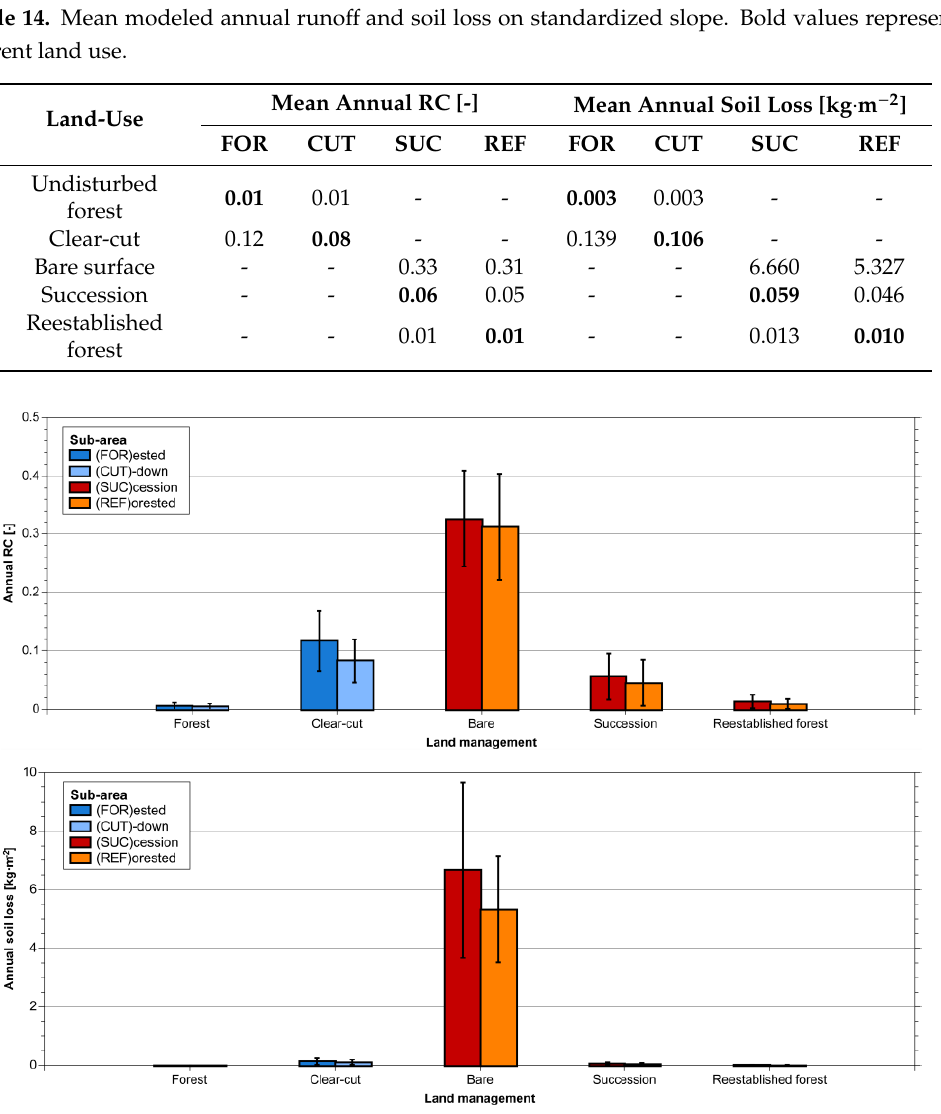
Figure 13. Modeling results for land management shifts on standardized slope, annual runoff coefficient (RC) and soil loss. Y-error indicates standard deviation, blue columns indicate undisturbed soils, red columns indicate disturbed soils.